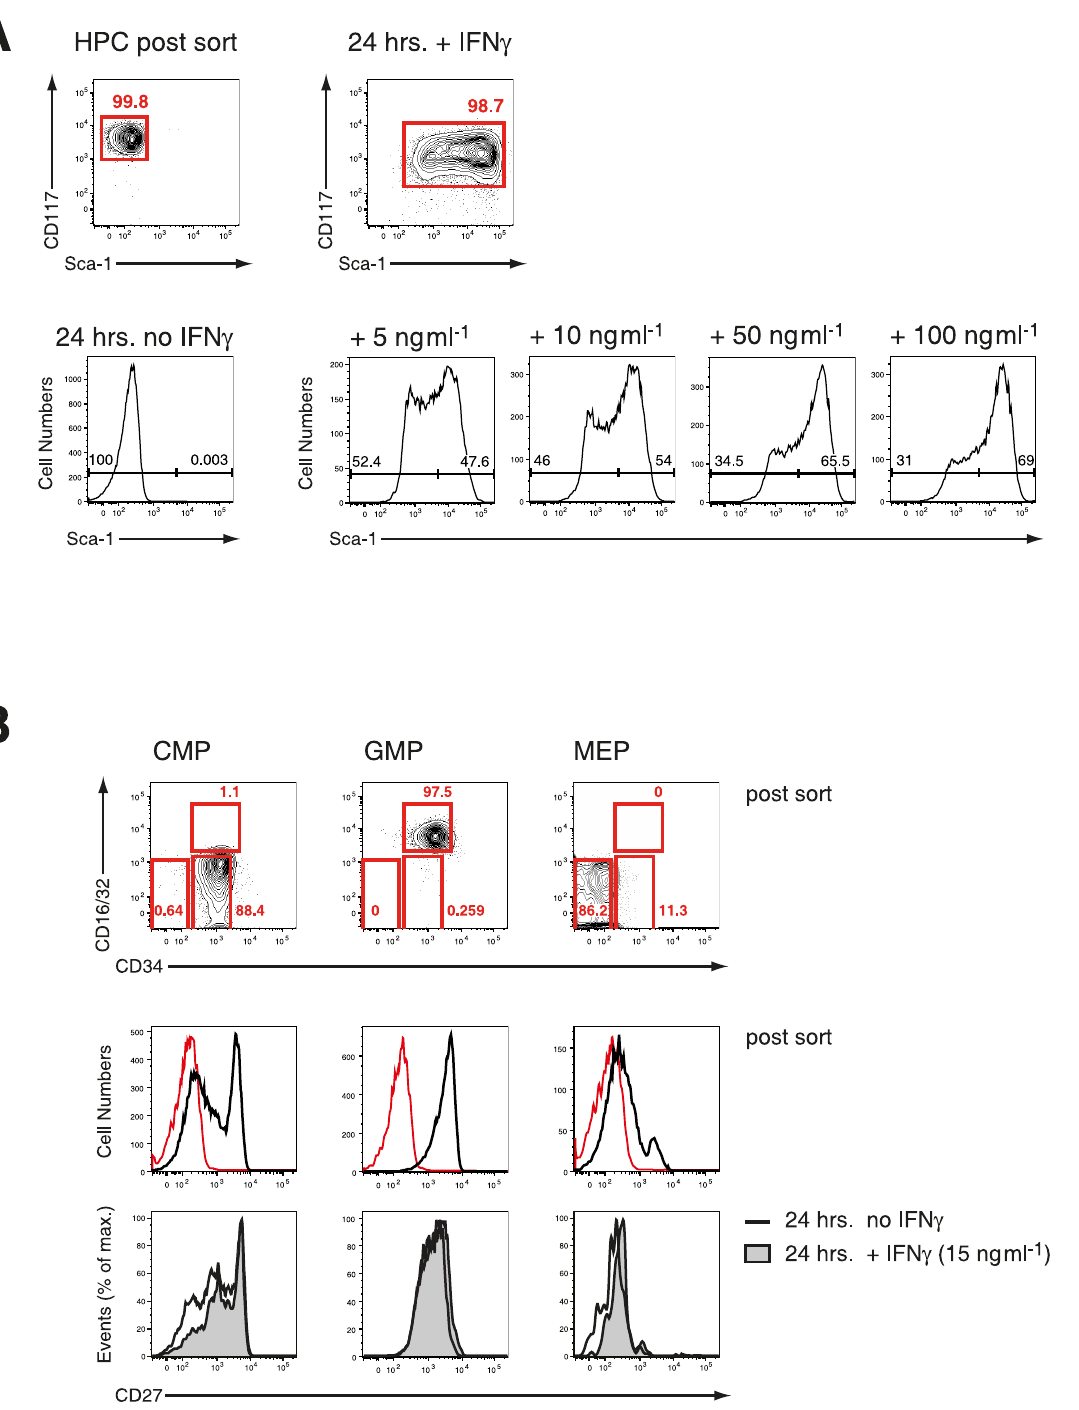
Figure 2. IFN- c in vitro effectively upregulates Sca-1 on HPCs without affecting expression of CD27. A. FACS-purified steady-state HPC were cultured in various concentration of IFN- c for 24 hrs in vitro . Representative histograms from three experiments are depicted. B. CMPs, GMP, MEP were FACS-purified from steady state HPCs and stained for expression of CD27 before (post sort, red line shows ‘‘fluorescence minus one’’ FMO control) and after culture with IFN- c for 24 hrs. Histograms from one of two experiments are shown.